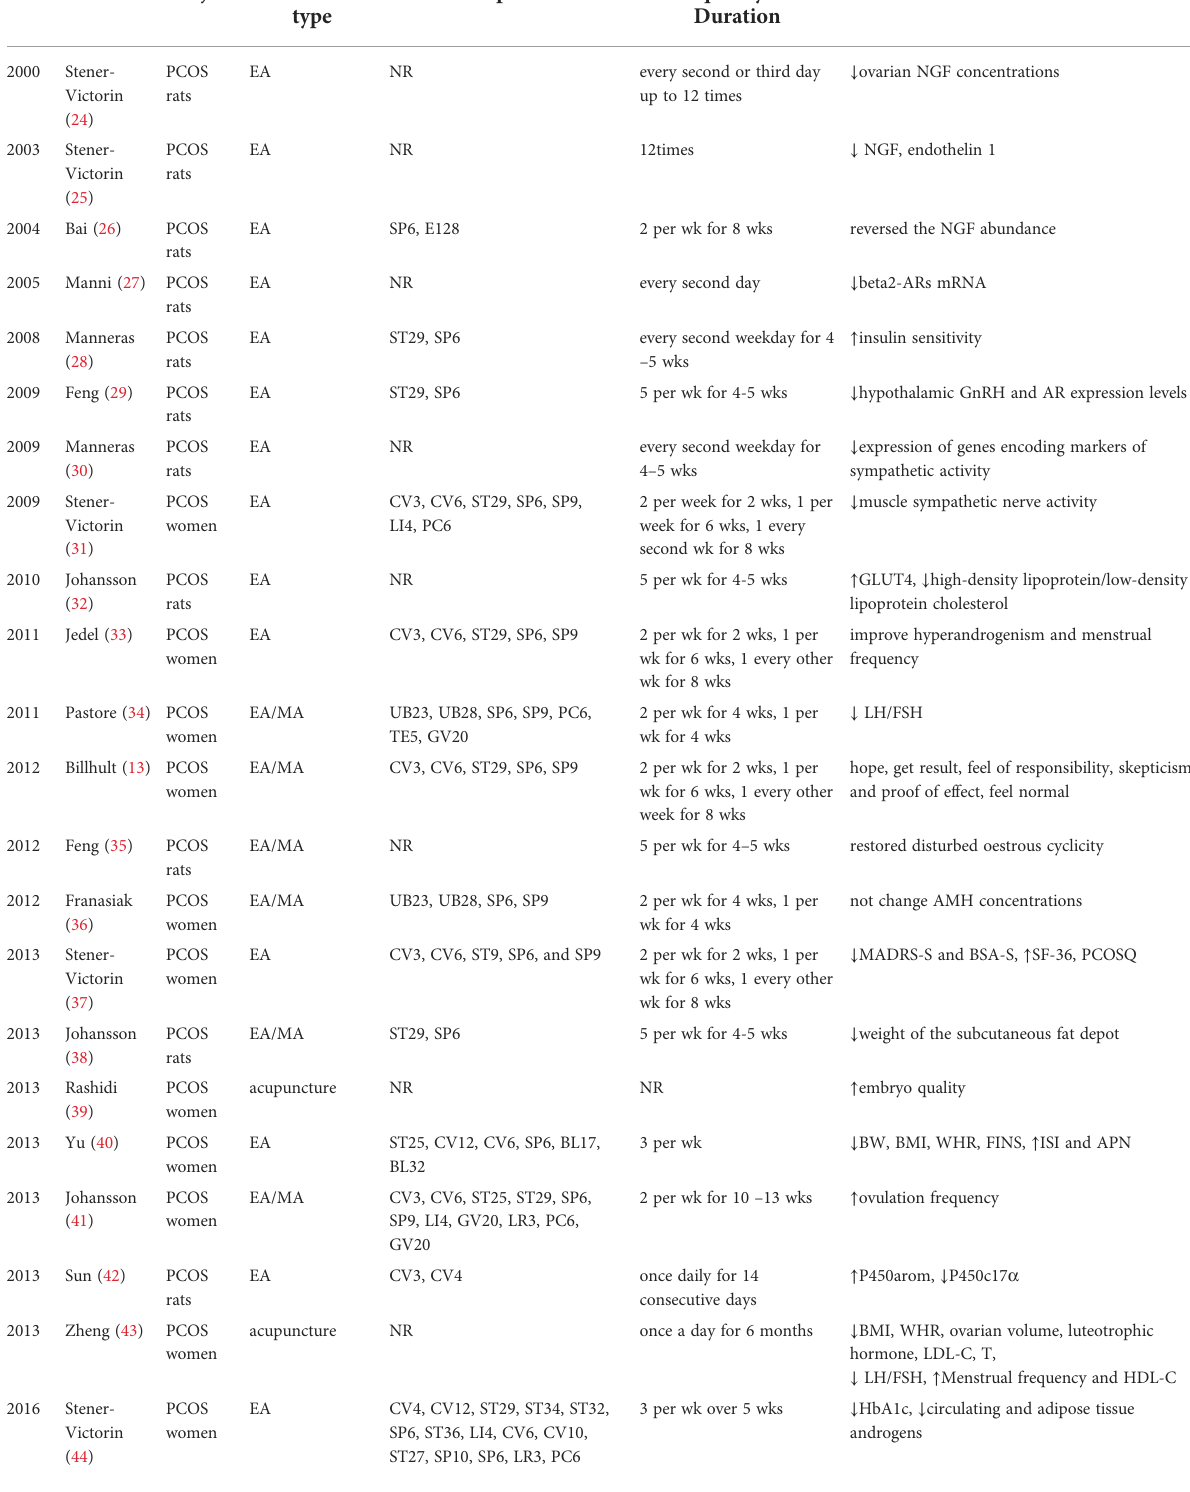
TABLE 1 Characteristics of acupuncture in the treatment of PCOS from main studies